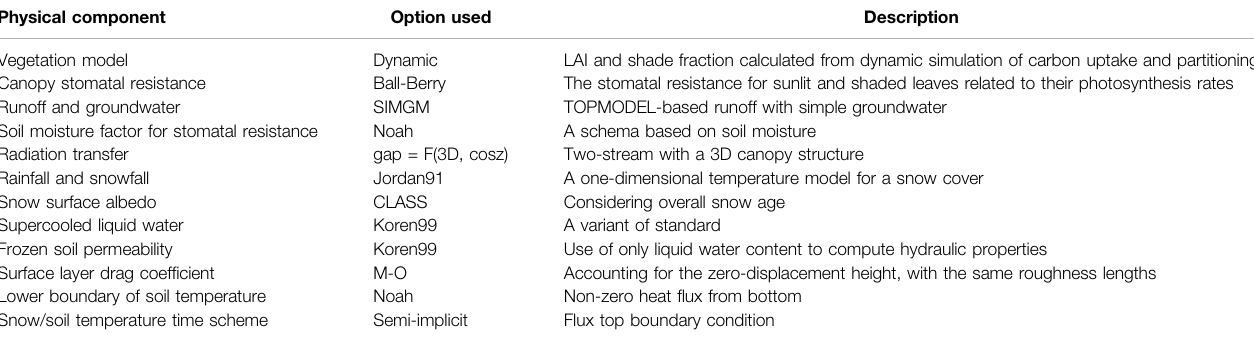
TABLE 1 | Optional Noah-MP parameterization schemes used in this study. Physical component Option used